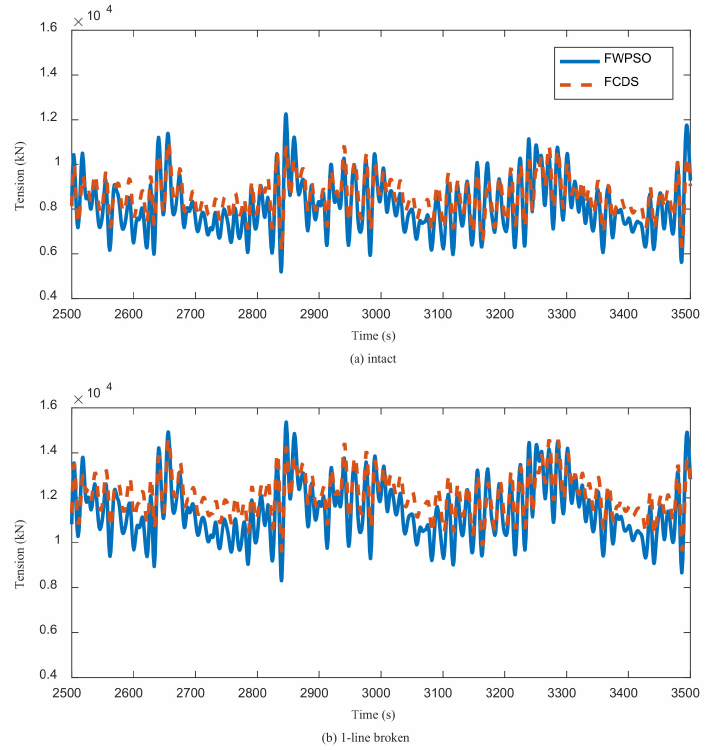
Figure 14. Time histories of the FCDS and FWPSO mooring tension under both mooring line